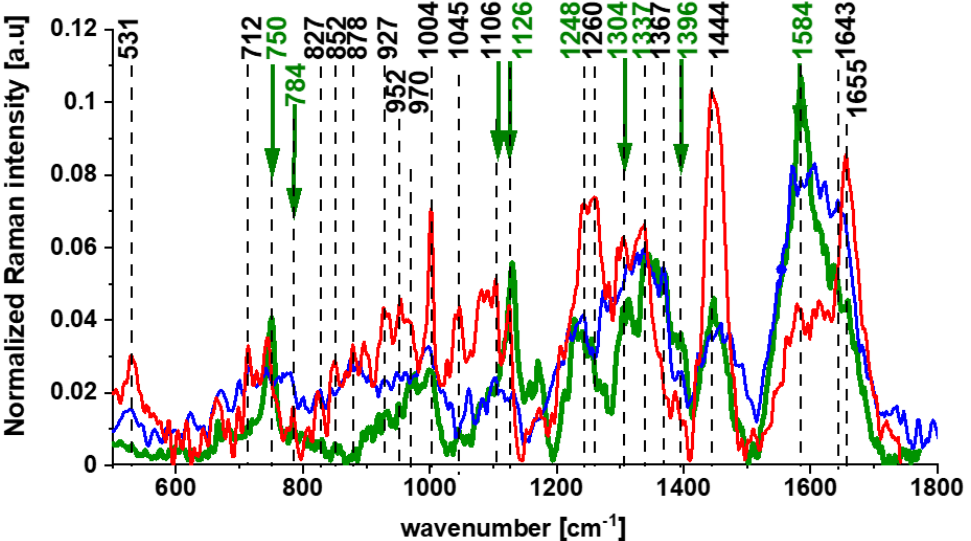
Figure 1. The average Raman spectra for the human brain tissue of medulloblastoma (grade of malignancy WHO G4) at different excitations (number of patients n = 6, for each patient thousands of Raman spectra obtained from cluster analysis) of the ex vivo tumor human brain tissue of medulloblastoma at the excitations 355 nm ▬ (blue), 532 nm ▬ (green) and 785 nm ▬ (red) for the same area of the samples.